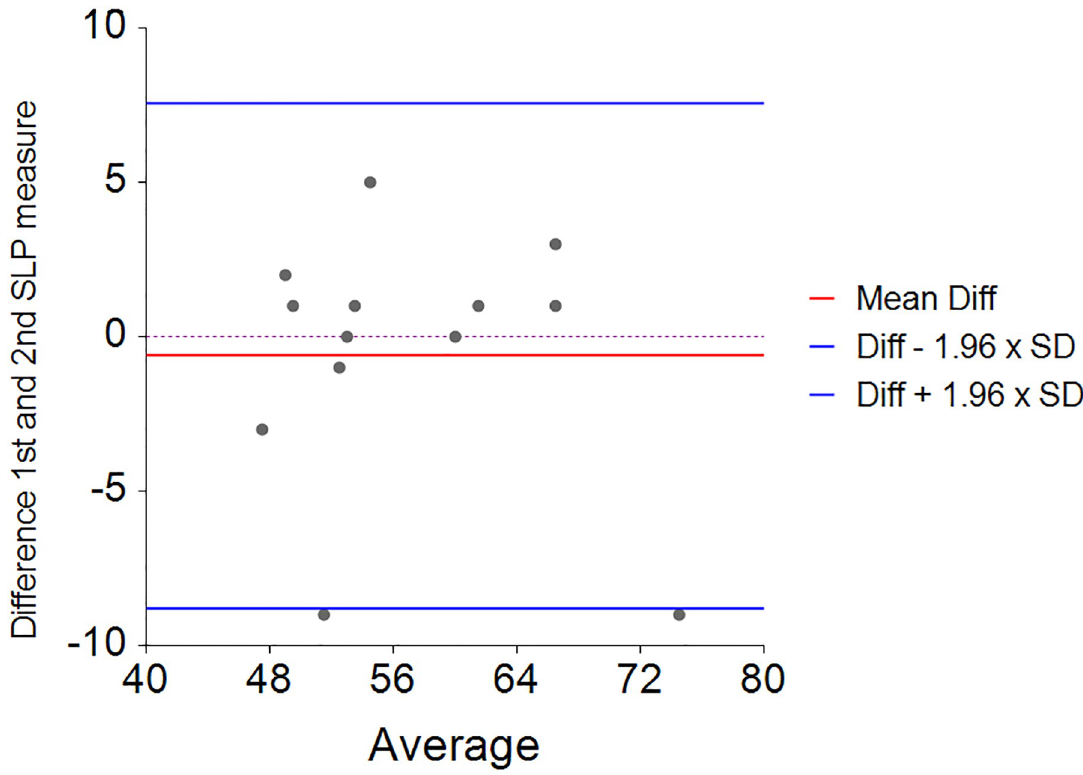
Fig 9. Bland and Altman plot of tidal breathing (SLP); 1st minus 2nd measurement and mean for percentage contribution of thoracic expansion in the control group.